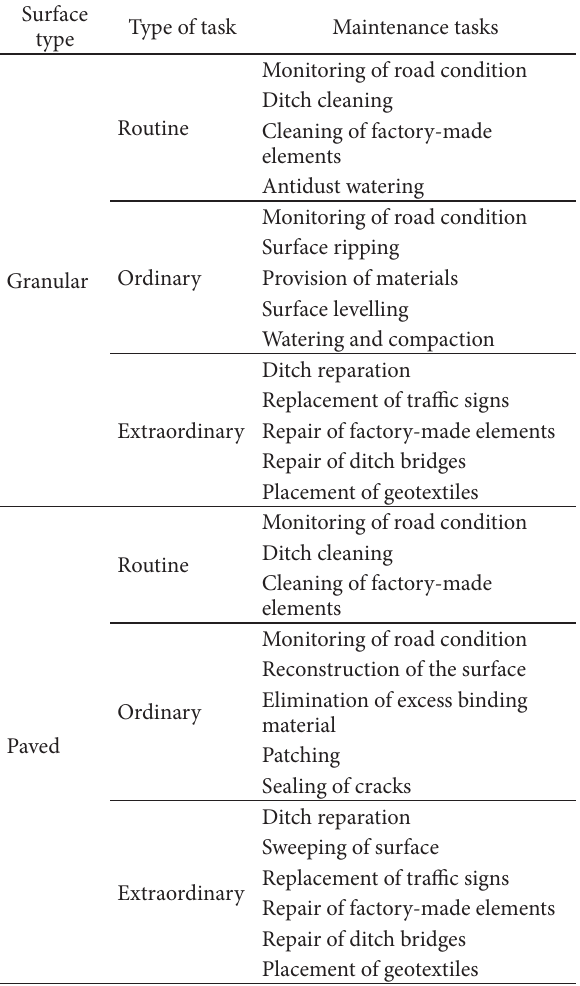
Table 5. Types of maintenance task required depending on the type of low-volume road